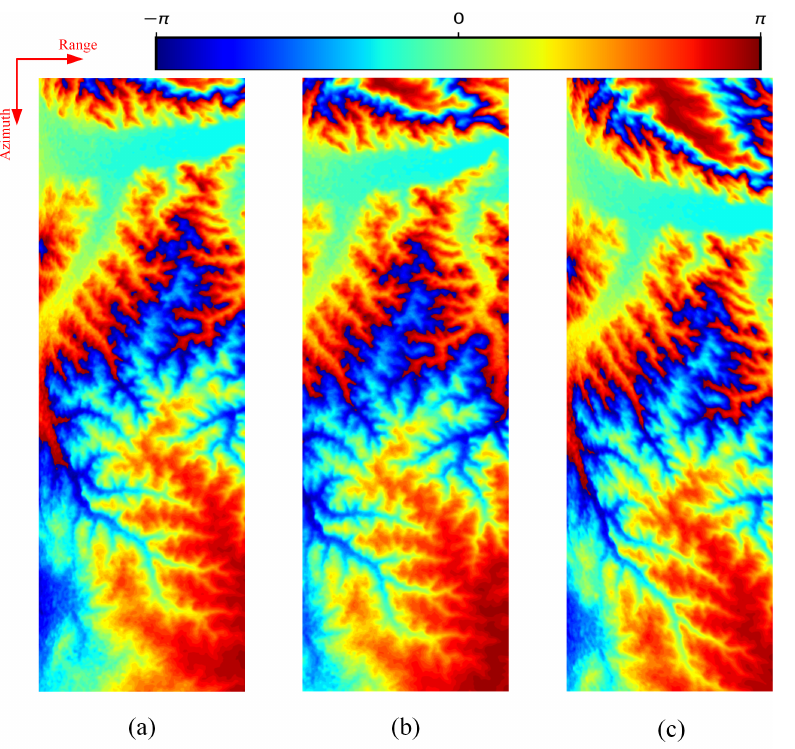
Figure 16. Reference interference fringe. ( a ) Reference interference fringe without errors. ( b ) Example of reference interference fringe with position errors. ( c ) Example of a reference interference fringe with attitude